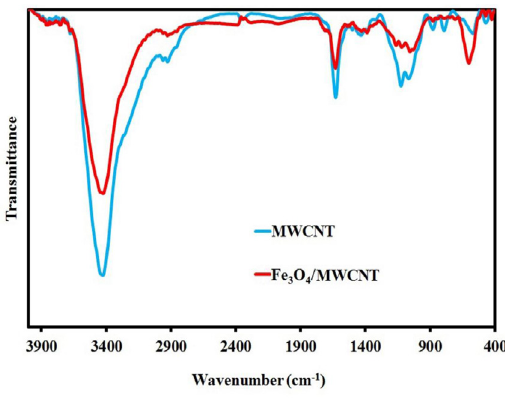
Fig. 2. FT-IR spectra of Fe